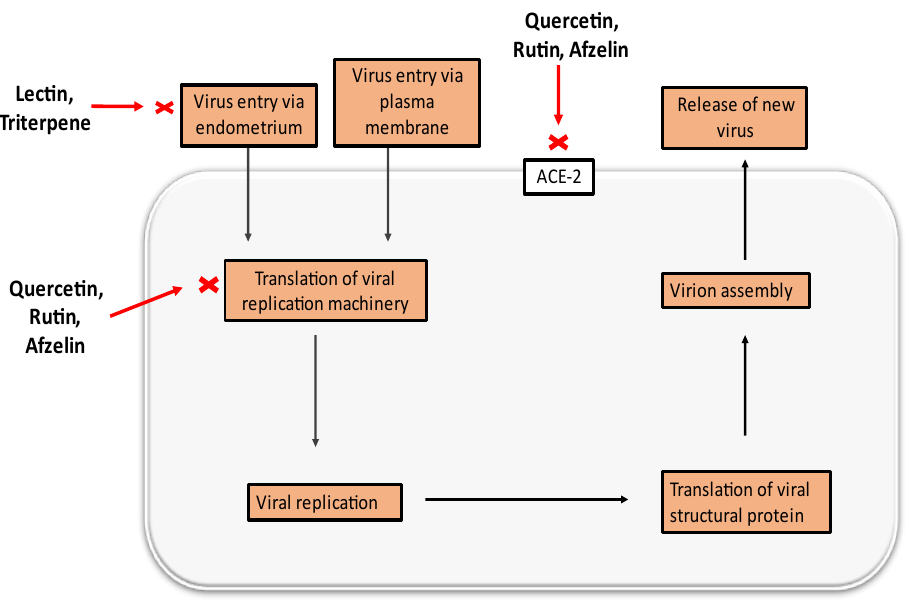
Figure 4. Possible antiviral activities of different constituents found in E. neriifolia to prevent COVID-